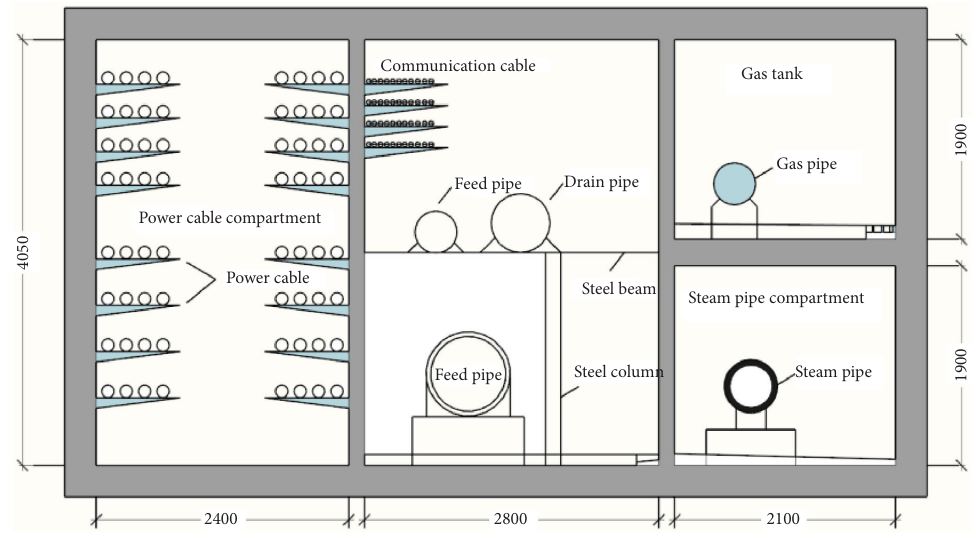
Figure 1: Standard segment section of utility tunnel. Table 1: Cable arrangement